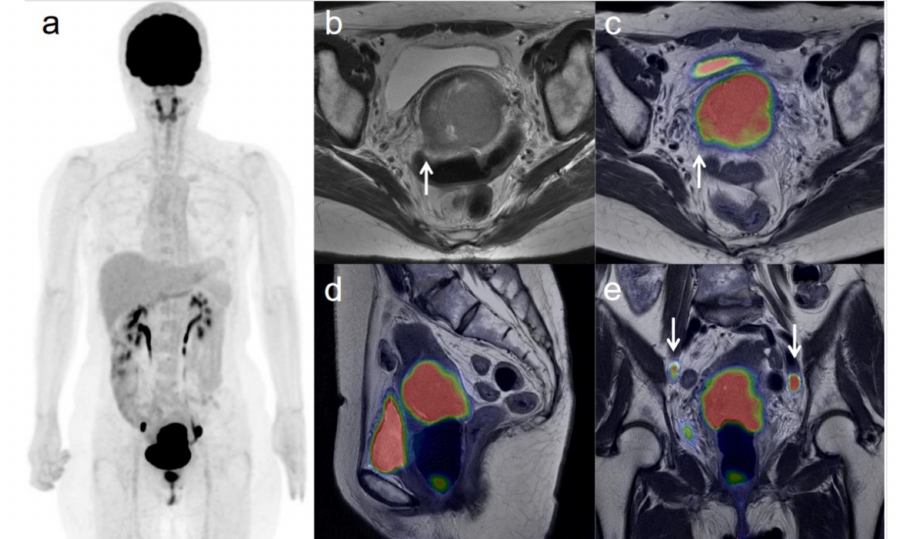
Figure 1. A 54-year-old woman with stage IIIC1 cervical cancer with parametrial invasion. ( a ) 18 F-FDG PET image shows FDG uptake by tumor in the cervical cervix (arrow) and pelvic lymph nodes. ( b ) Axial T2-weighted pelvic MR image shows parametrial invasion with disruption of the right cervical stroma by the tumor but no extension into the pelvic side wall (arrow). ( c ) Axial T2-weighted PET/MR image shows FDG uptake by the tumor, which invades the right parametrium with disruption of the cervical stroma, but no extension into the pelvic side wall (arrow). These appearances are consistent with the clinical findings. ( d ) Sagittal T2-weighted PET/MR image shows FDG uptake by the cervical tumor. ( e ) Coronal T2-weighted PET/MR image shows FDG uptake by the cervical tumor and pelvic lymph nodes